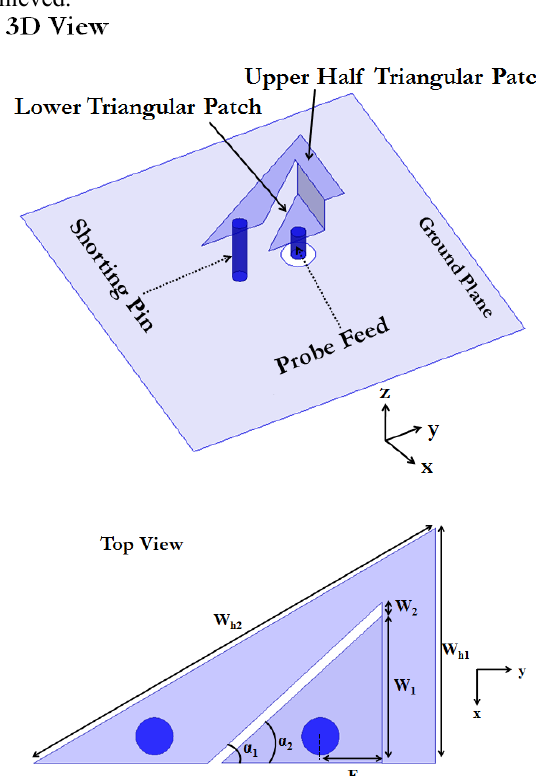
FIGURE 2 . Structure of the suggested half triangular patch antenna with half V-shaped slot. Based on the transmission line model for the rectangular radiating patch, the basic width ( W ) and length ( L ) of the patch at the resonant frequency are determined